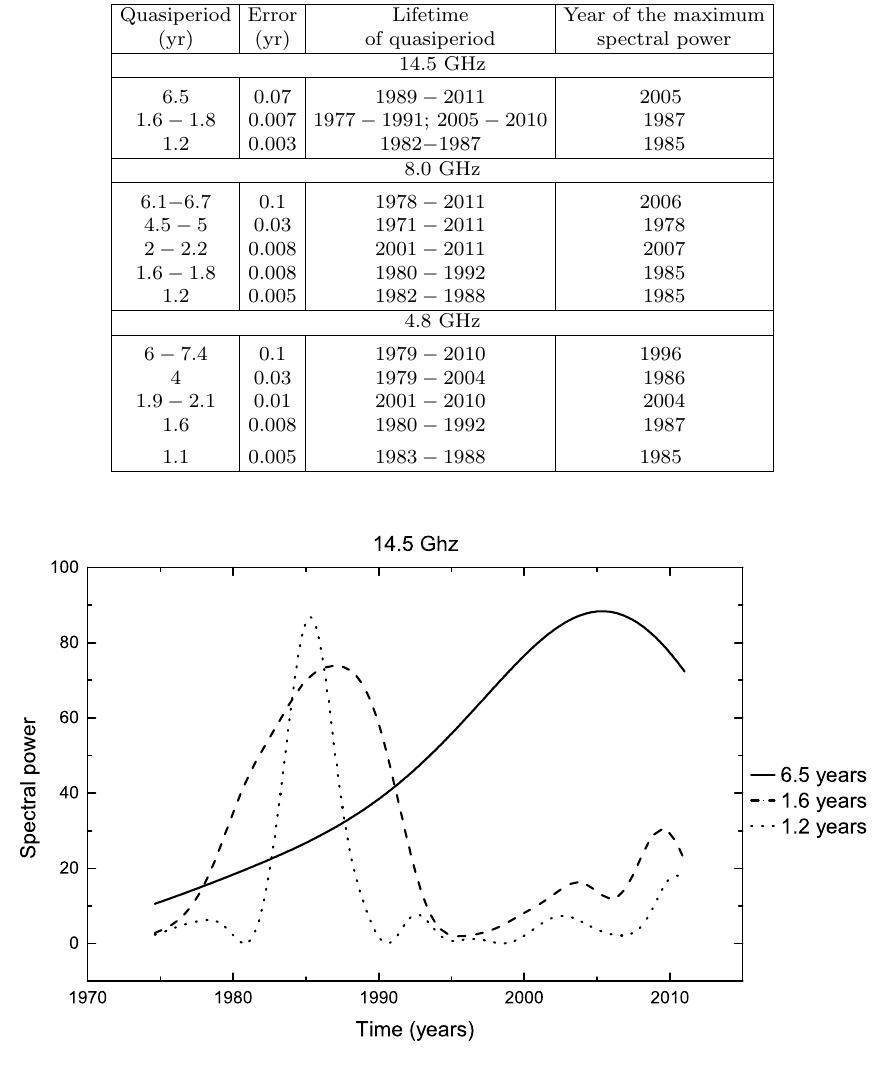
Fig. 3. The periods obtained by the wavelet analysis at 14.5